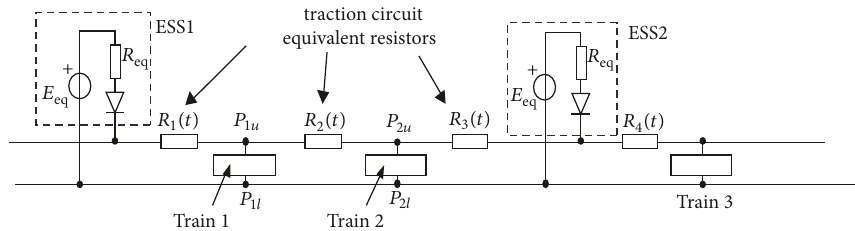
Figure 3: Graphical representation of the electrical feeding system.